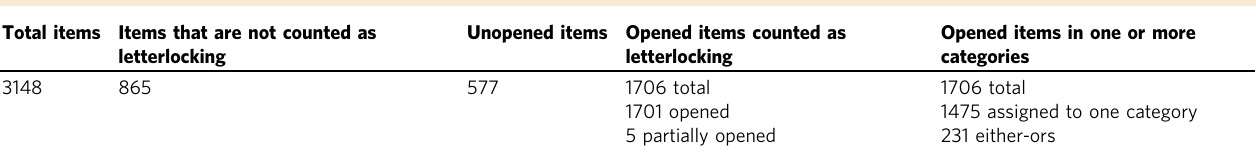
Fig. 7 Letterlocking categories and formats chart. Letterlocking categories 1 – 64, based on manipulations and assigned security score. Filled letterlocking category numbers indicate that historic originals exist; un fi lled numbers indicate hypothetical categories. Letterlocking formats show up to 12 edges with indicative examples. Table 1 Breakdown of Brienne Collection by